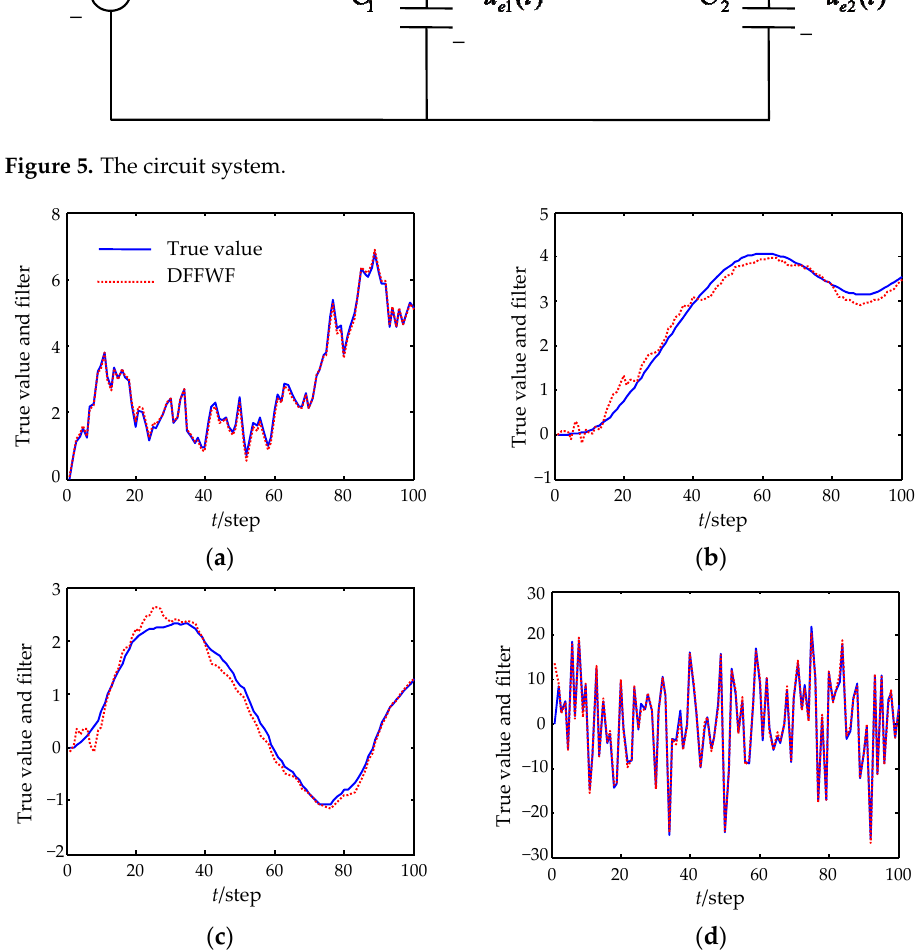
C . ( b ) The voltage of C . ( c ) The 1 2